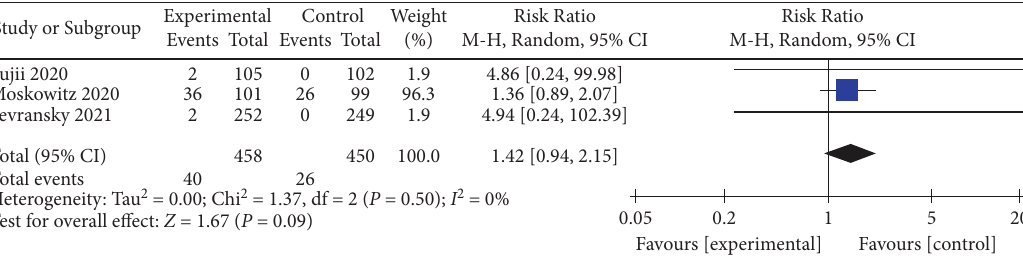
Figure 12: Forest plots for the efects of vitamin C on the adverse event.